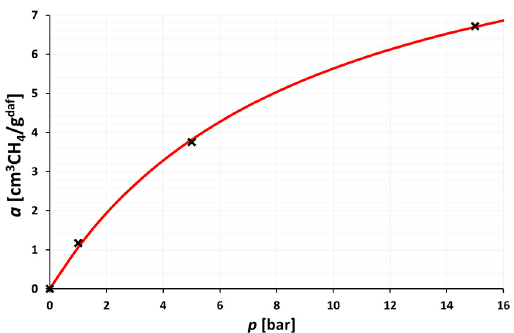
Figure 7. Methane sorption kinetics after normalisation of the adsorbed amount (high-rank coal 4030).